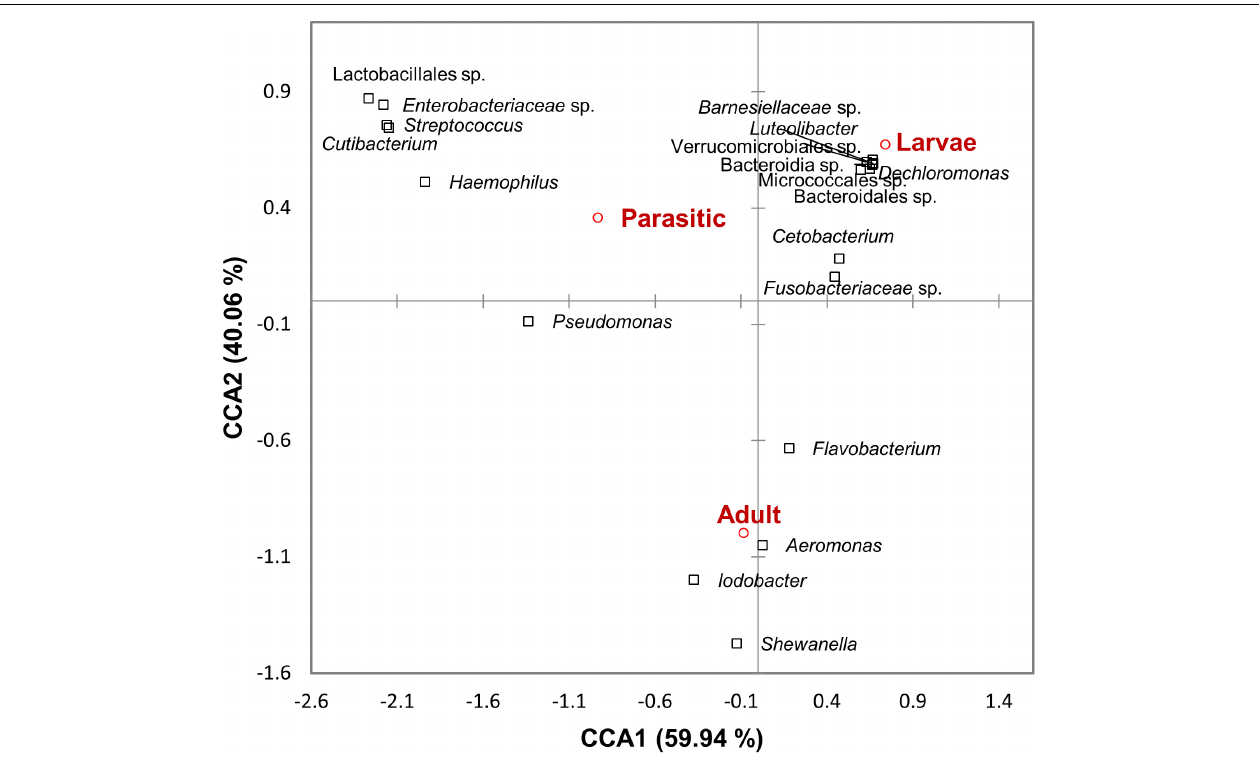
FIGURE 5 | Canonical correspondence analysis ordination diagram correlating microbial taxa and sea lamprey ( Petromyzon marinus ) life stages. The first two axes and the proportion of constraint variance they explain are